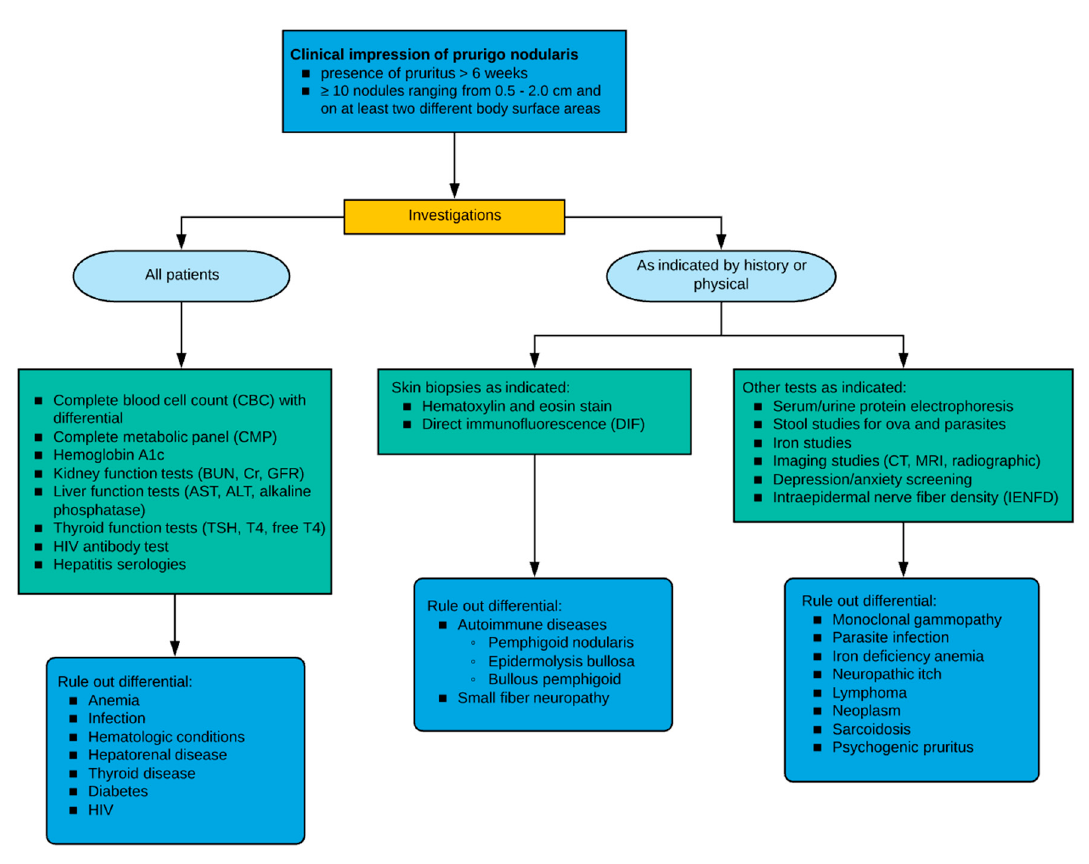
Figure 2. Diagnostic approach and workup for patients with prurigo nodularis.